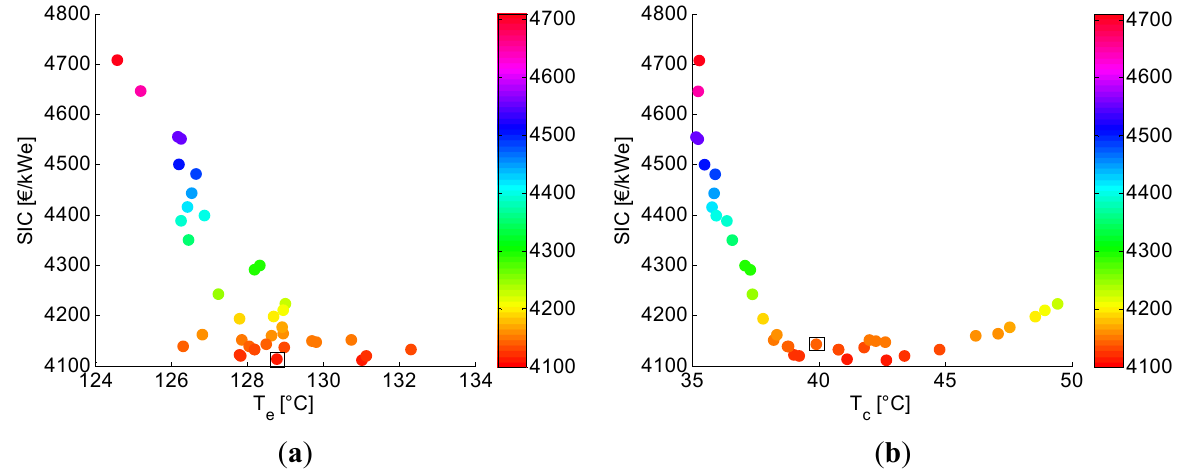
) for the SCORC. (cid:3041)(cid:3032)(cid:3047)